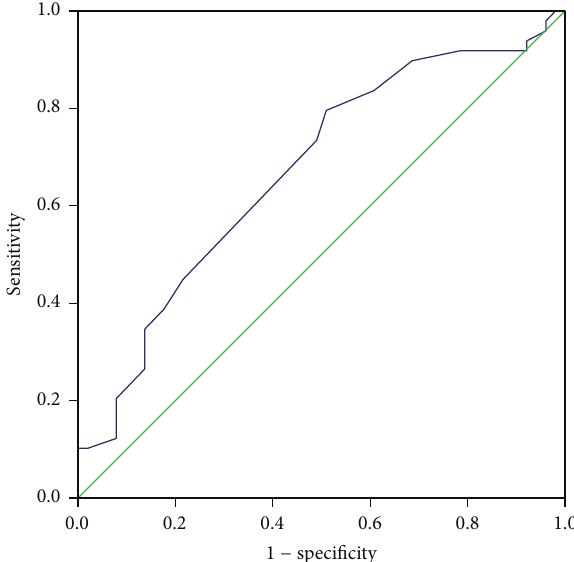
Figure 2: Receiver operating characteristic (ROC) curve to detect the best cutoff value for albumin in the prediction of systemic hypertension in sarcoidosis patients. AUC value of 0.670 (95% CI 0.564–0.776, 𝑃 = 0.003 ). An albumin level < 3.3 gm/dL yielded a 35% sensitivity and 87% specificity for predicting systemic hypertension in sarcoidosis